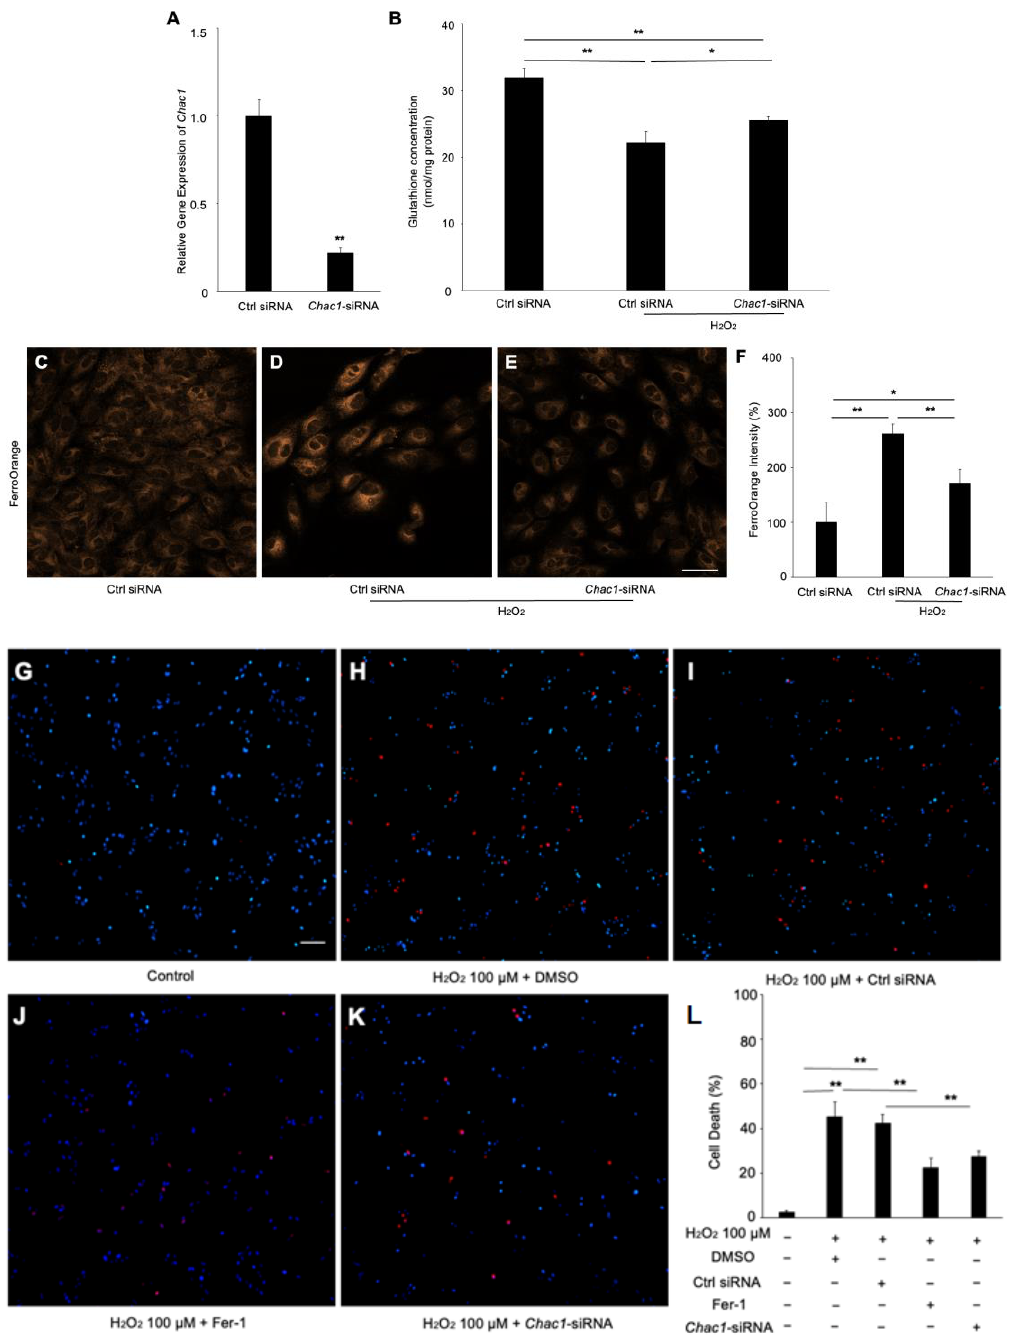
Figure 6. The effect of Chac1 silencing on ferroptosis and cell death of RPE cells treated with hydro- gen peroxide. ( A ) Gene silencing effect of Chac1 siRNA in ARPE-19 cells. ( B ) GSH assay. ( C – F ) Rep- resentative fluorescent images and quantitative analysis of intracellular iron level in ARPE-19 cells using FerroOrange (orange). ( G – L ) Cell death analysis using PI staining. Scale bar, 50 μm. n = 5 in each group. * p < 0.05, ** p < 0.01.